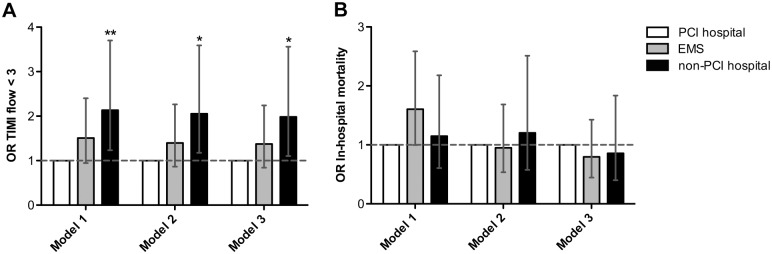
Logistic regression analyses of type of first medical contact (FMC) on procedural results and in-hospital mortality.Odds ratios (OR) of (A) TIMI flow < 3 and (B) in-hospital mortality by type of FMC unadjusted (Model 1), adjusted for baseline characteristics (age, gender, history of stroke, heart rate > 100/min, systolic blood pressure < 100 mmHg, cardiogenic shock) and symptom-to-contact time (Model 2), and adjusted as Model 2 plus contact-to-balloon time (Model 3). OR are indicated by bars, with the lines representing corresponding 95% confidence intervals. The horizontal line indicates no difference between type of FMC. * p < 0.05, ** p < 0.01.